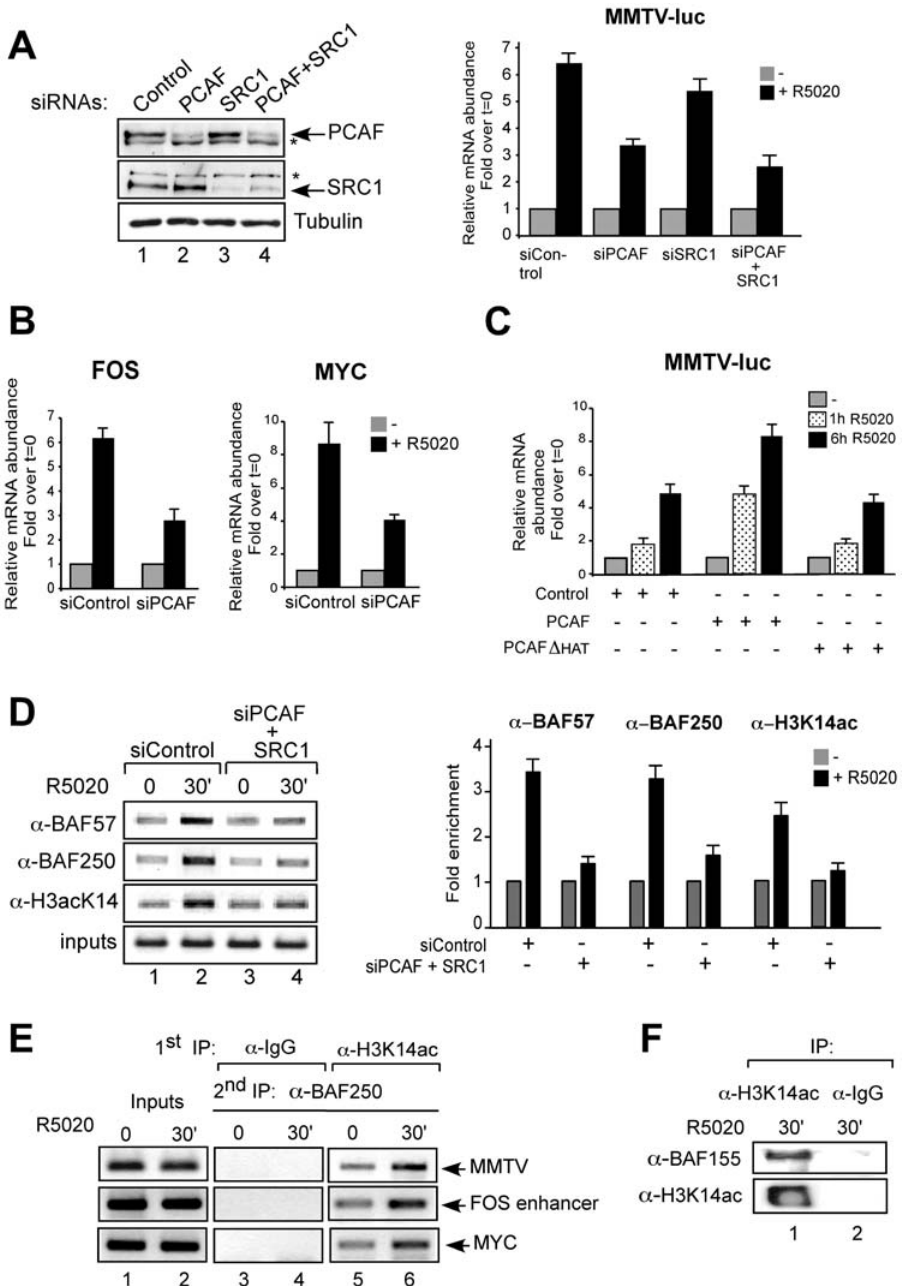
Figure 3. Acetylation on histone H3K14 by PCAF is essential for hormonal transactivation in T47D-MTVL cells. (A) Left: Cells were transfected with the indicated siRNAs and the levels of PCAF, SRC1, and tubulin were determined by Western blotting. The asterisks indicate inespecific bands. Right: Cells were transfected with the indicated siRNAs and treated with 10 nM R5020 for 6 h. RNA was extracted, cDNA was generated and used as template for real time PCR with luciferase oligonucleotides. The values represent the mean and standard deviation from 3 experiments performed in duplicate. (B) Cells were transfected with siRNAs, treated with 10 nM R5020 as indicated and the levels of c-Fos and c-Myc mRNAs were analyzed by RT–PCR. The values represent the mean and standard deviation from 2 experiments performed in duplicate. (C) Cells were transfected with PCAF or PCAF HAT mutant (PCAF D HAT), treated with hormone as indicated and transcription from the MMTV promoter was determined as in (B). An empty vector was used as control. The values represent the mean and standard deviation from 2 experiments performed in duplicate. (D) Left: Cells transfected with the siRNAs and treated with hormone as indicated were subjected to ChIP assays with a -BAF57, a -BAF250 and a -K14acH3. The precipitated DNA fragments were subjected to PCR analysis to test for the presence of sequences corresponding to the MMTV nucleosome B. A representative of three independent experiments is shown. Right: quantification of the results by real time PCR from two experiments performed induplicate. (E) Cells were treated with R5020 as indicated and subjected to re-ChIP assays with a -H3K14ac and IgG (first IP) followed by a -BAF250 for the second IP. Precipiated DNA was analysed by PCR for the presence of sequences corresponding to the MMTV, c-Fos and c-Myc PR binding regions. (F) Cells were treated for 30 min with R5020, lysed and chromatin was immunoprecipitated either with a -H3K14ac or with normal rabbit IgG as a negative control (IgG). IPs were analyzed by western blot using a -BAF155 and a -H3K14ac.